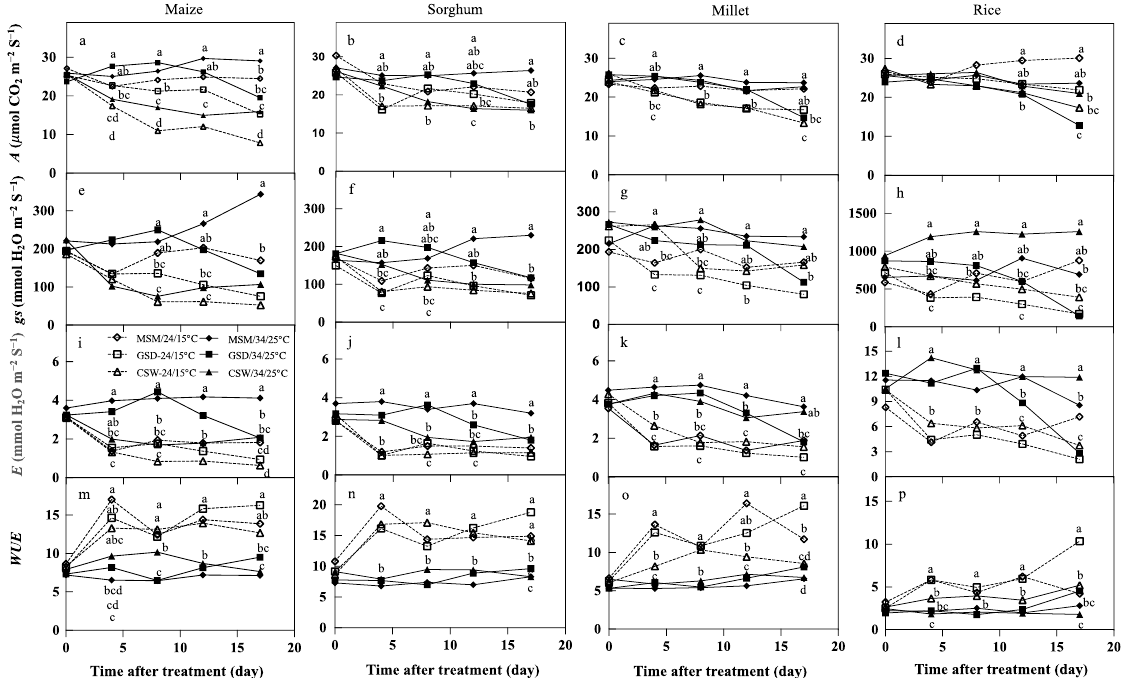
Figure 5. The effect of combination of soil moisture status and temperature on changing of photo- synthesis rate ( A ; a – d ), stomatal conductance ( gs ; e – h ), transpiration rate ( E ; i – l ), and water use ef- ficiency ( WUE ; m – p ) in maize ( a , e , i , m ), sorghum ( b , f , j , n ), common millet ( c , g , k , o ), and rice ( d , h , l , p ) during the course of experiment 2. Each day of measurement with similar letters did not signifi- cantly differ according to Tukey’s test at the 0.05 probability level.